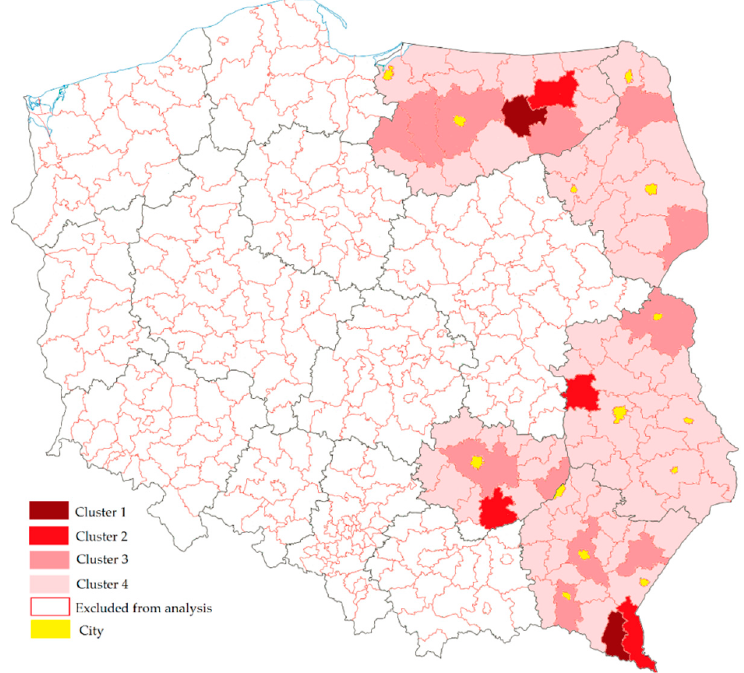
Figure 1. Counties grouping based on the cluster analysis. Source: this research.